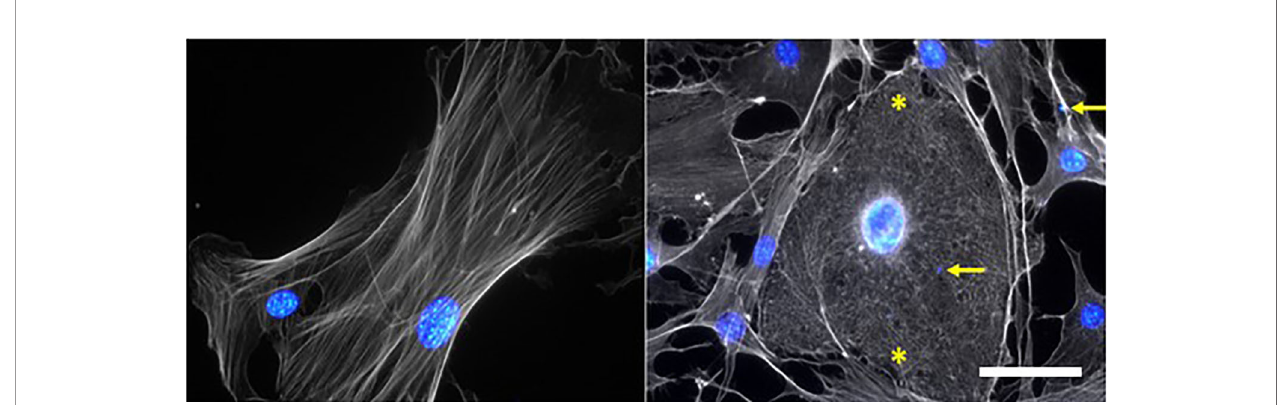
FIGURE 1 | P. berghei ANKA-infected red blood cells (PbA-iRBCs) generate morphological alterations in the cytoskeleton of primary pulmonary endothelial cells (PMLECs) of DBA/2 mice. Non-stimulated (NS) cell show elongated actin micro fi laments, while adhered PbA-iRBCs cause shortening and entanglement of these fi laments, indicated by asterisks. Actin and cell nuclei were stained with Texas Red Phalloidin], Hoechst [1:1000], respectively. Yellow arrows point to PbA-iRBCs nuclei; Scale bar: 50 m